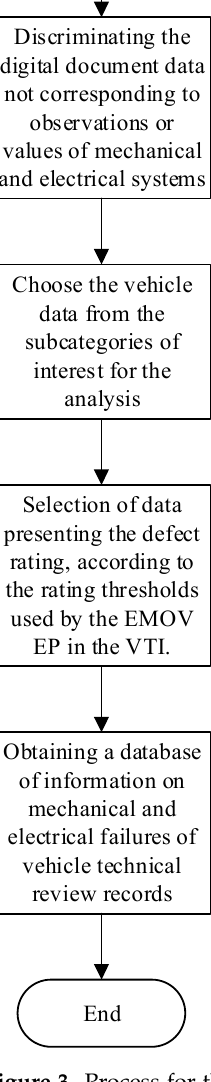
Figure 3. Process for the database creation of the mechanical and electrical failures from the VTI records.